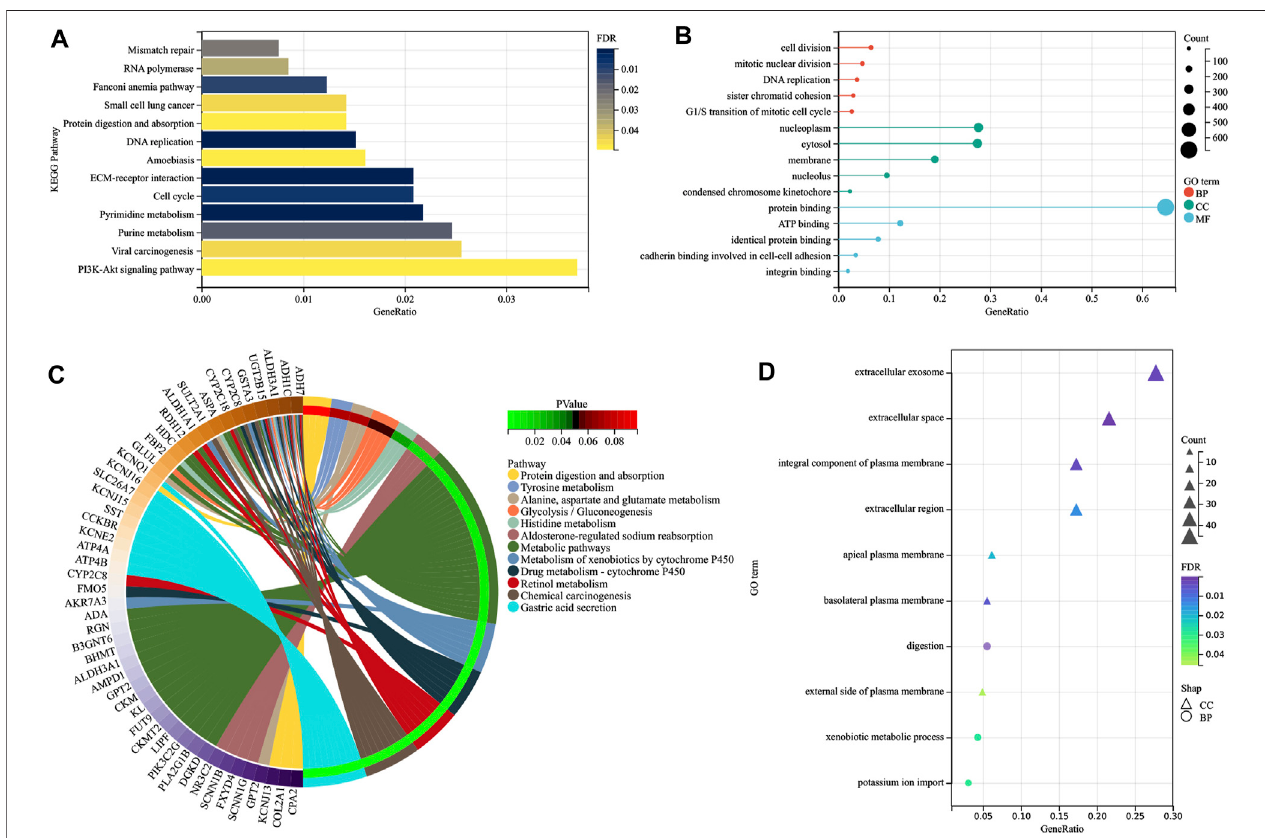
FIGURE4| Visualizationoftheenrichmentresults.DistributionoftheupregulatedDEGsinGCfordifferent (A) KEGGpathwaysand (B) GO-enrichedfunctions,and distribution of the down -regulated DEGs in GC for different (C) KEGG pathways and (D) GO-enriched functions. DEGs, differentially expressed genes; GC, gastric cancer; KEGG, Kyoto Encyclopedia of Genes and Genomes; GO, Gene ontology; BP, biological process; CC, cellular component; MF, molecular function.